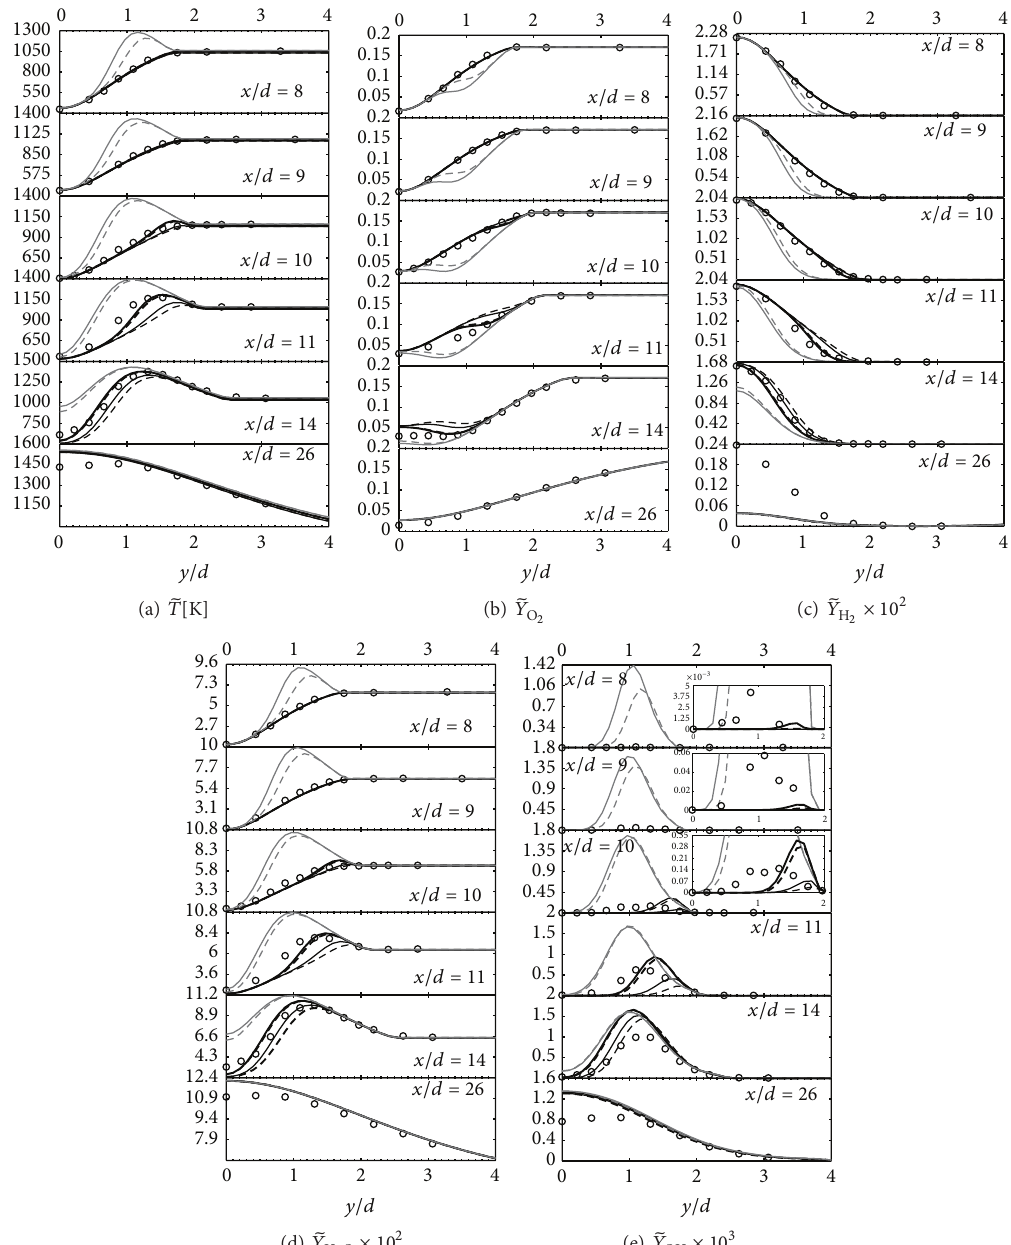
̃𝑇 ̃𝑌 ̃𝑌 (×10 2 ) , (d) ̃𝑌 (×10 2 ) (e), and ̃𝑌 (×10 3 ) using Girimaji’s and Mortensen’s models for the , (b) , (c) O 2 H 2 H 2 O OH